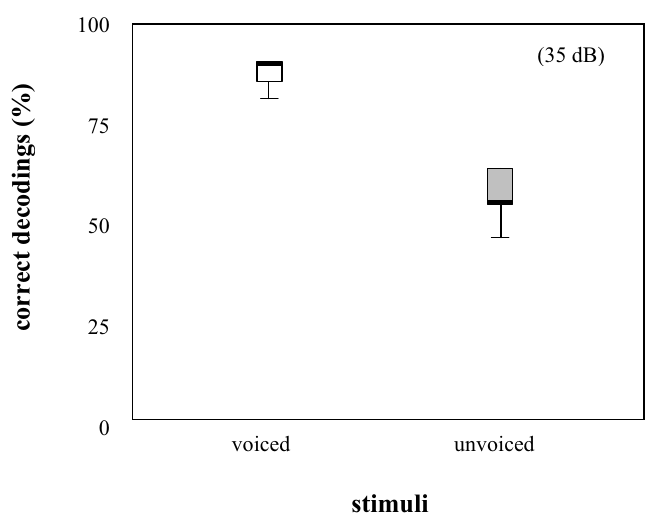
Fig. 5 – Boxplots showing the proportion of correctly decoded stimuli plotted against stimulus quality, here: phonated numbers (left) or whispered numbers (right). Stimuli were presented through headphones with an amplitude of about 35 dB in addition to environmental noise that was played-back with an amplitude of about 45 dB and served to test masking